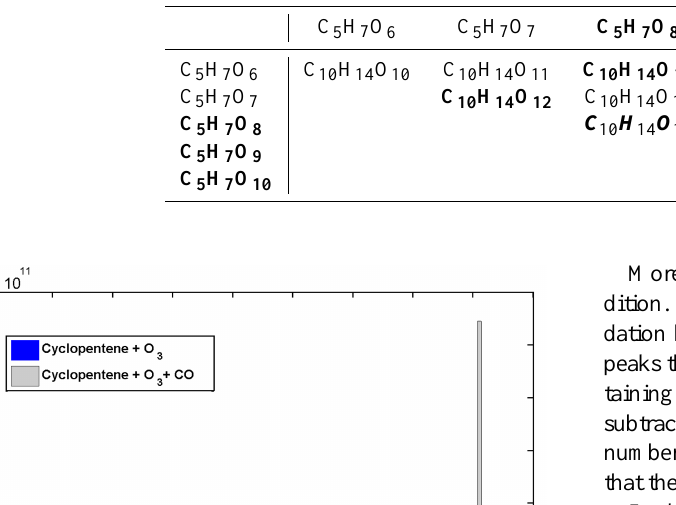
Table 15. Possible dimers produced by permutations reactions of the monomer peroxy radicals of cyclopentene. Bold face: entities were detected. Italic: dimers were detected and arise from two most abundant peroxy radicals.